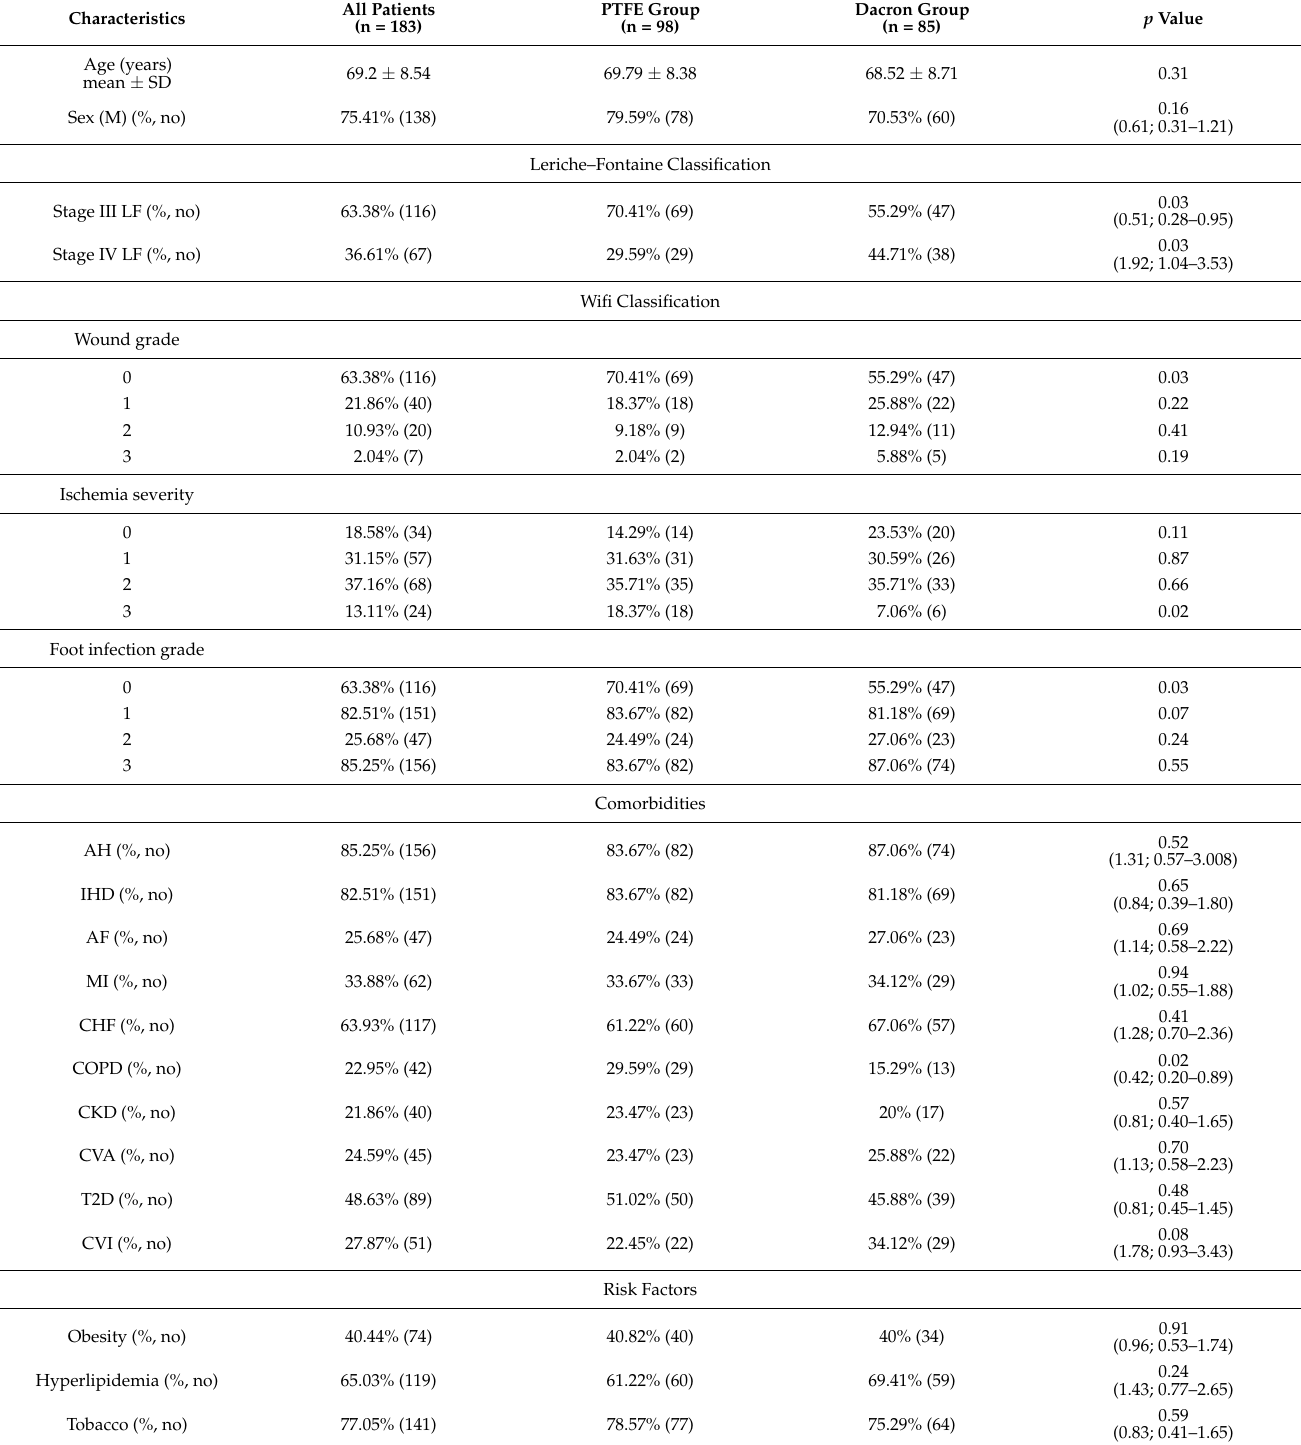
Table 1. Characteristics, demographics, comorbidities, and risk factors of